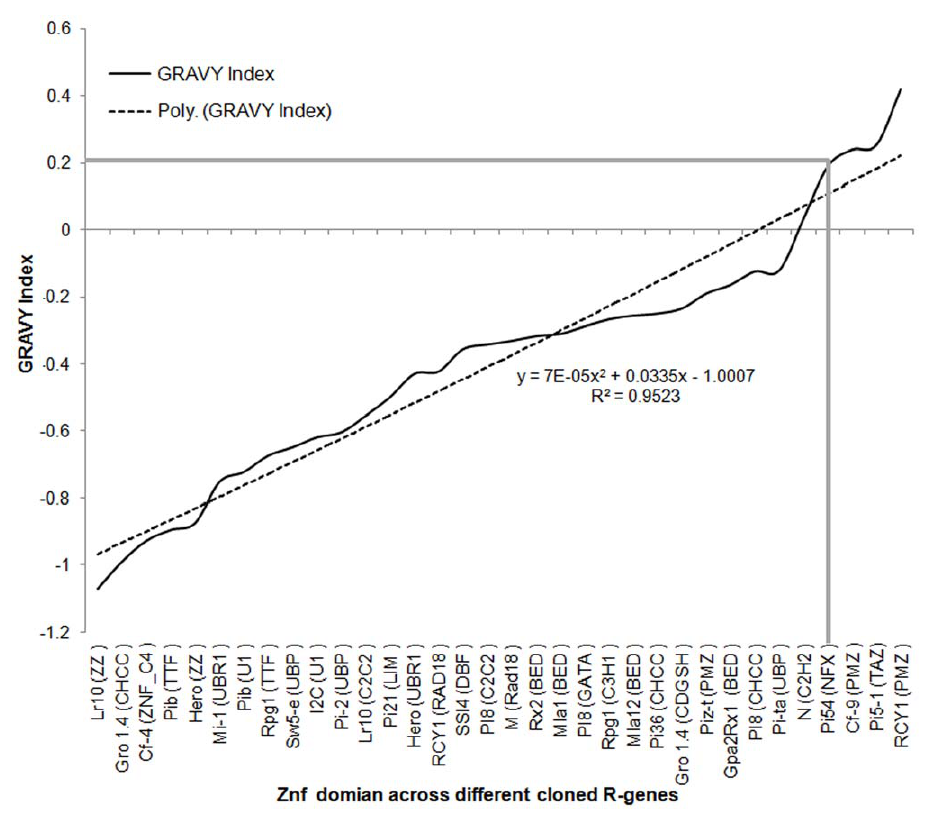
Figure 6. Grand Average of hydropathicity index profile of identified zinc finger domain across cloned R gene. The data of 26 zinc finger R genes with their zinc finger types were included in this analysis.